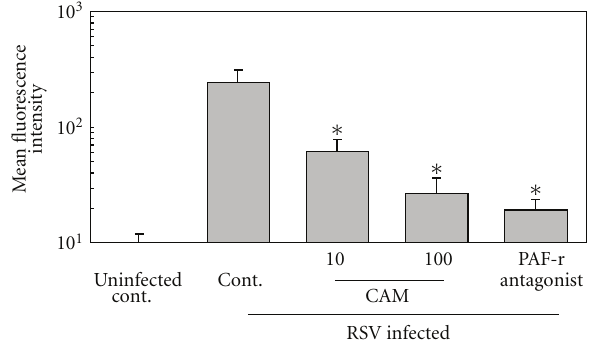
Figure 5: Suppression by CAM of RSV-induced adhesion of FITC-labeled S. pneumoniae to A549 cells, as observed by flow cytometry. Experiments were performed as in Figure 5. The A549 cell monolayer incubated with FITC-labeled S. pneumoniae cells was harvested by cell scraper and then applied to flow cytometry. Each experiment was performed in triplicate. The data present as mean value ± standard deviation of the mean relative fluorescence intensity. ∗ P < 0 . 01 compared to RSV-infected cells without any reagent